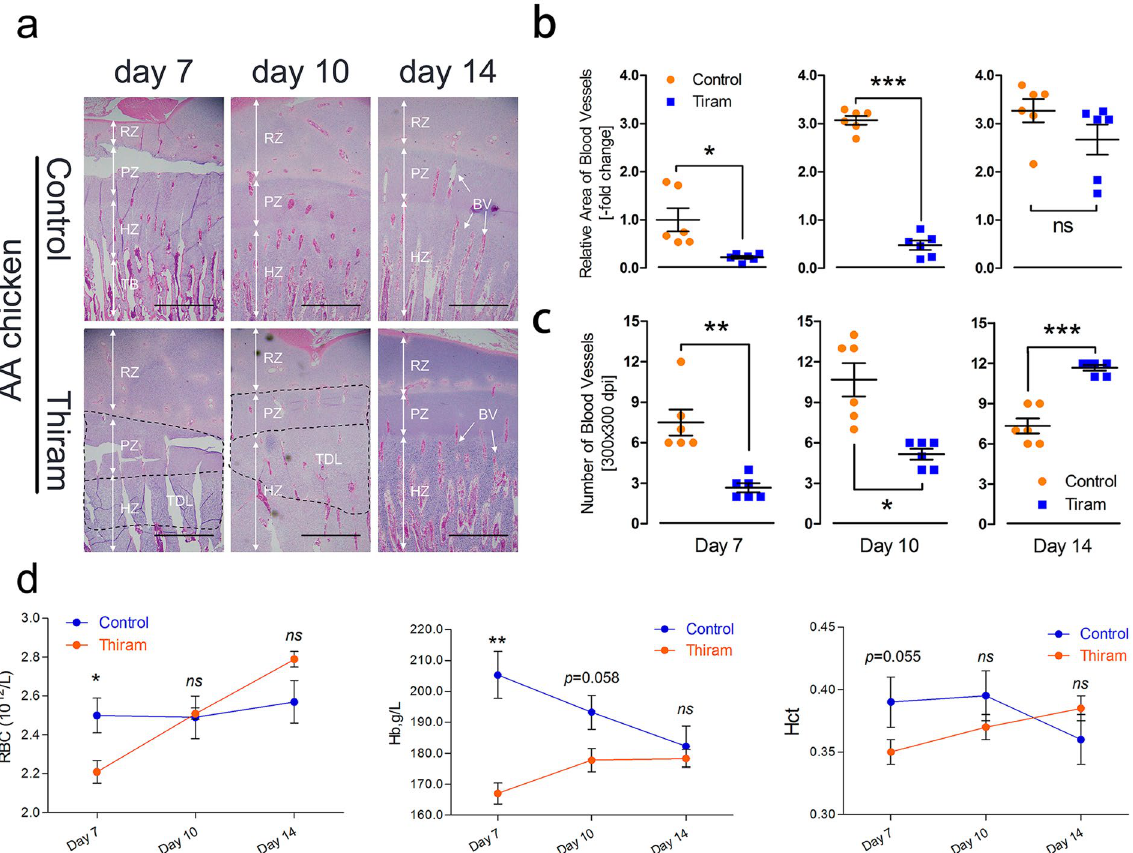
Figure 7. Thiram suppresses tibial vascular distribution in the hypertrophic chondrocyte zones of AACs. ( a ) Tibial vascular distribution was significantly inhibited in the Thiram-treated group compared to the control group. The arrows indicate the BVs (blood vessels); TDL, tibial dyschondroplasia lesion; RZ, resting chondrocyte zone; PZ, proliferative chondrocyte zone; HZ, hypertrophic chondrocyte zone; and TB, trabecular bone. Scale bar = 500 µ m. ( b , c ) The relative BV area and number were determined from two isolated groups using Image-Pro ® Plus 6.0. Student’s t -test, * p < 0.05, ** p < 0.01, *** p < 0.001, n = 6; Error bars indicate SD. ns, not significant. ( d ) RBC (red blood cell) counts, Hb (hemoglobin) levels and Hct (hematocrit) values were determined for all blood samples. Student’s t -test, * p < 0.05, ** p < 0.01, n = 6; Error bars indicate SEM. ns, not